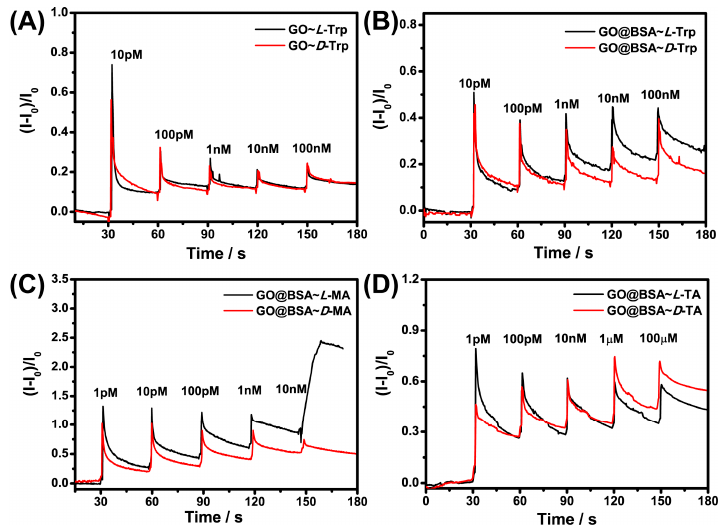
Figure 6. Real time detection curve of Nafion–GO-EG-MOSFET and Nafion–GO@BSA–EG-MOSFET for ( A , B ) Trp, ( C ) MA and ( D ) TA enantiomers.